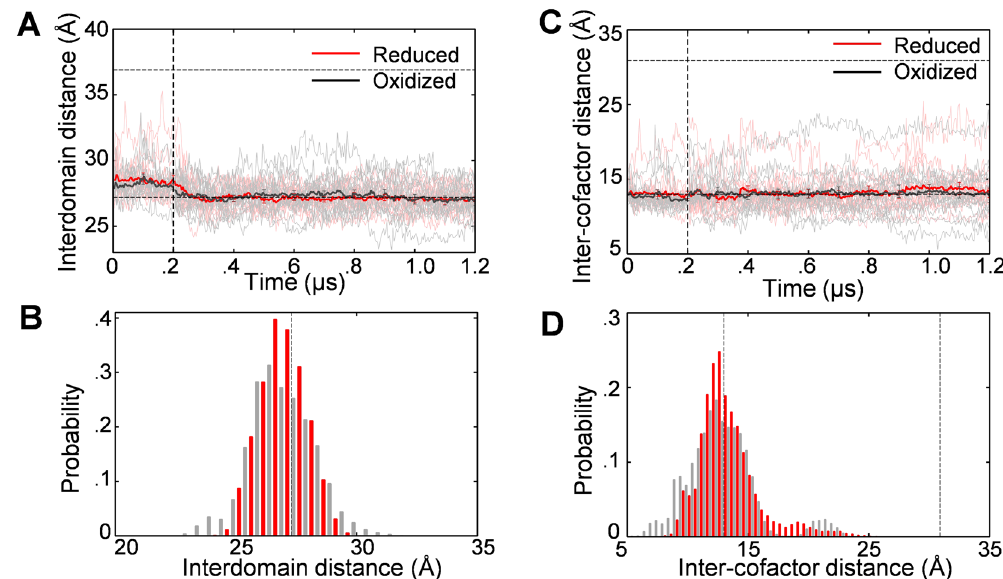
Figure 3. Effect of the bound NADP + on the redox-state dependence of the structural state. The same as in Figs 1B,C and 2A,B except that the bound NADP + was